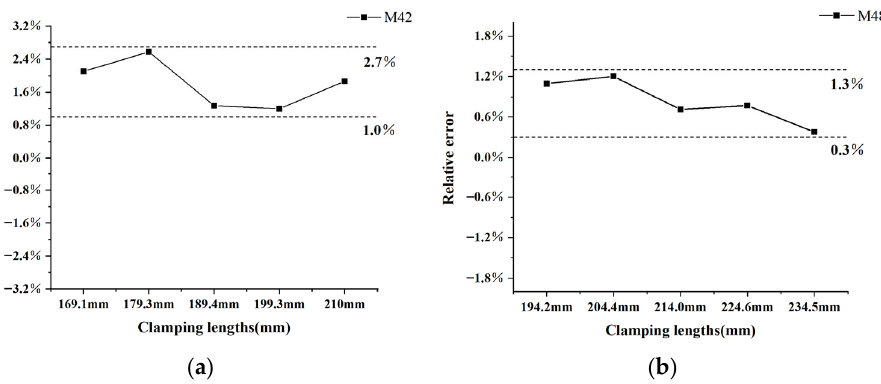
Figure 8. Measurement error of preload under different clamping lengths for ( a ) M42 bolt; ( b ) M48